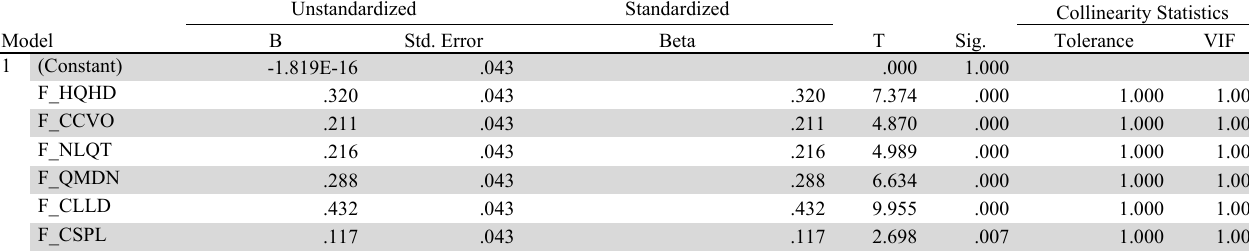
Regression coefficient